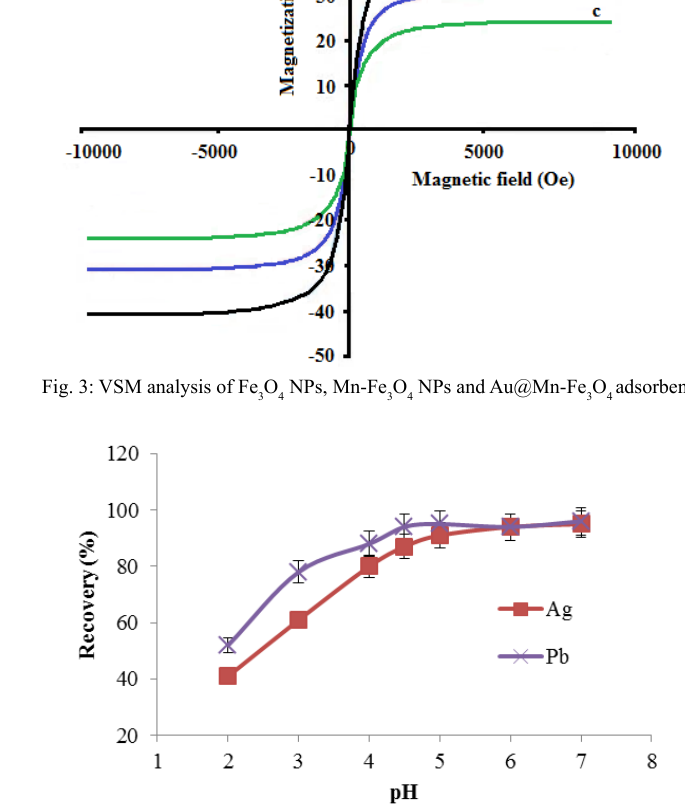
Fig. 4: Effect of pH on the recovery of targeted metal ions. Sample volume; 200 mL, adsorbent amount; 100 mg, extraction time; 5 min, desorption time; 2 min, and eluent solvent; 0.1 M